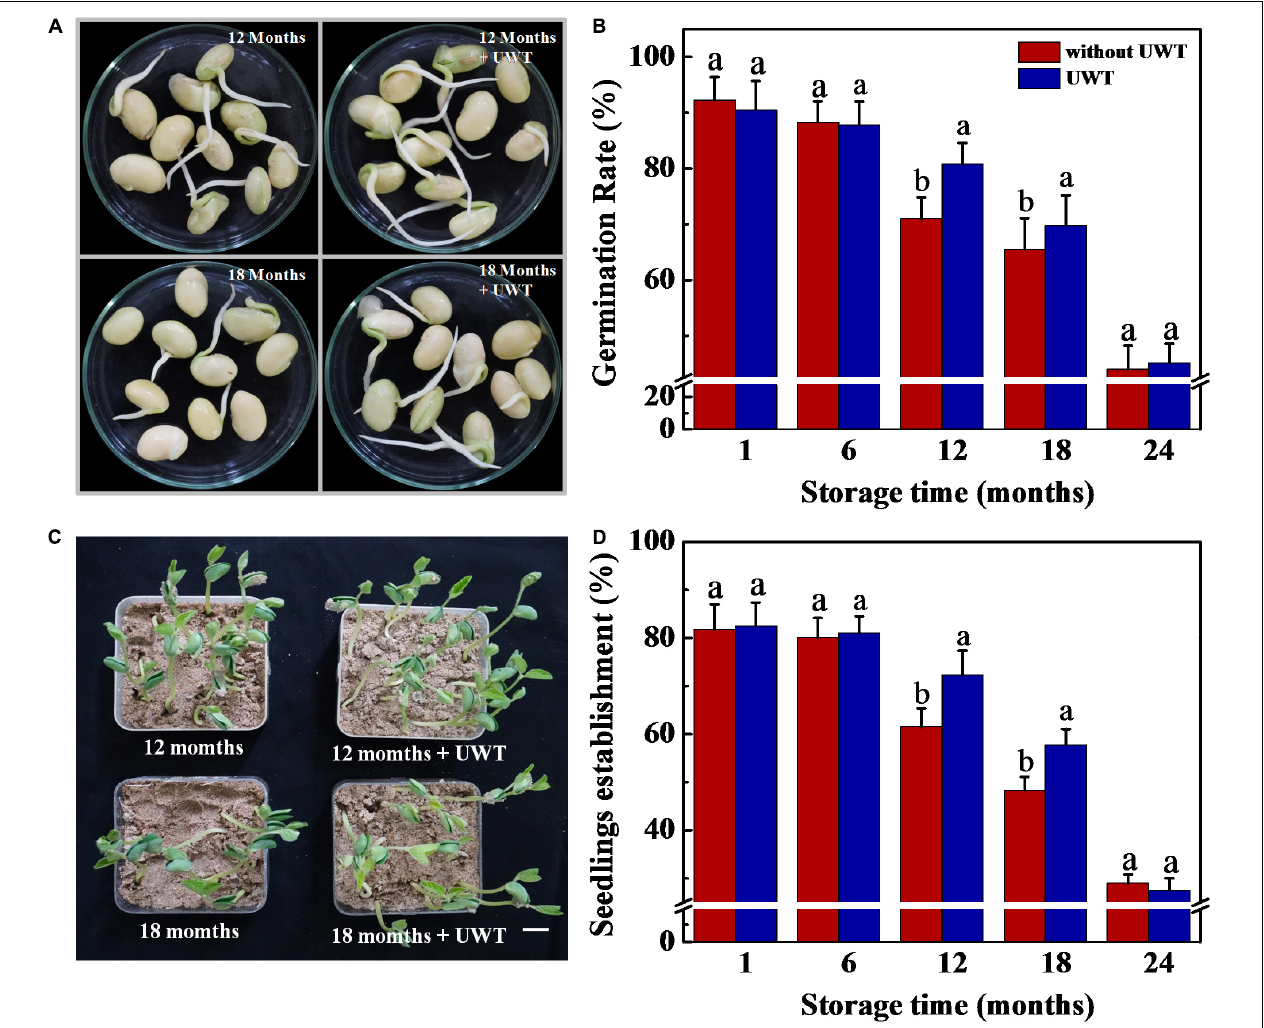
FIGURE 2 | Ultrasonic waves treatment promoted germination and seedling establishment of NAT soybean seeds. (A) Images of soybean seeds at 3 days of germination. Scale bar, 10 mm. (B) Germination rates of soybean seeds at 5 days of germination. (C) Images of seedling emergence from soybean seeds at 5 days post-sowing. Scale bar, 600 mm. (D) Seedling emergence rates of soybean seeds at 5 days postsowing. Soybean seeds stored for 1, 6, 12, 18, and 24 months were used for analysis. NAT, naturally aging treatment; UWT, ultrasonic waves treatment. Different lowercase letters indicate significant differences between different treatments ( p <